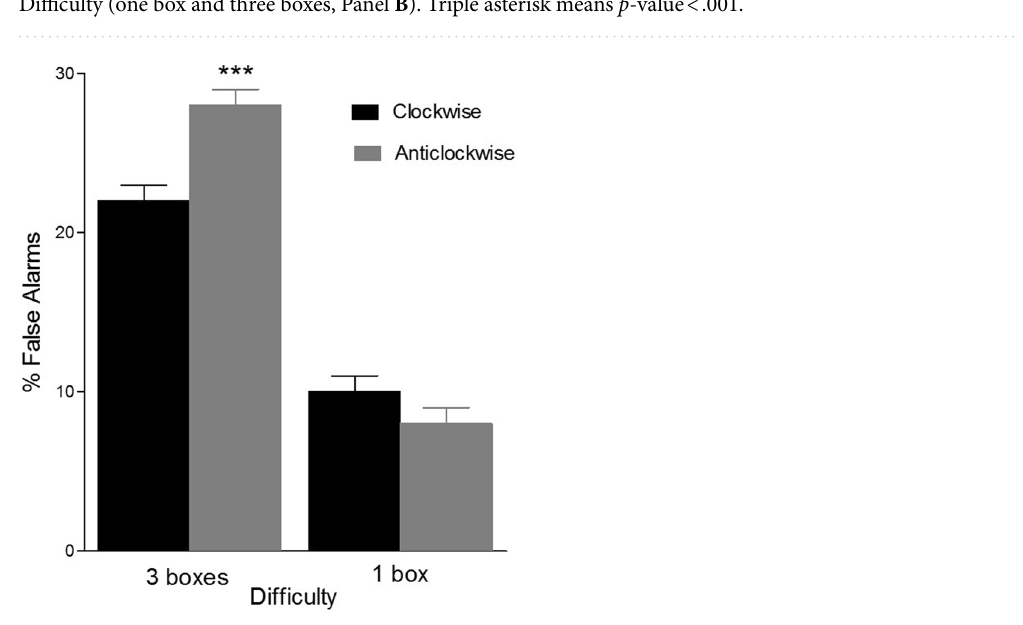
scores in the lower difficulty level (one box: M = 0.88, SD = 0.02) vs. the higher difficulty level (three boxes: M = 0.86; SD = 0.02). The Direction x Difficulty interaction was also statistically significant ( F (1, 76) = 6.8; p = 0.016; η p2 = 0.10). Analyses of the interaction showed that Direction affected performance only in the higher difficulty level (three